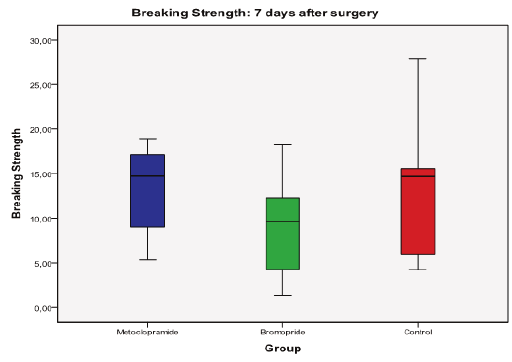
FIGURE 2 - Distribution of abdominal wall wound breaking strength (expressed in newtons) seven days after surgery. Group M (metoclopramide) shown in blue, group B (bromopride) shown in green, and group C (control) shown in red.